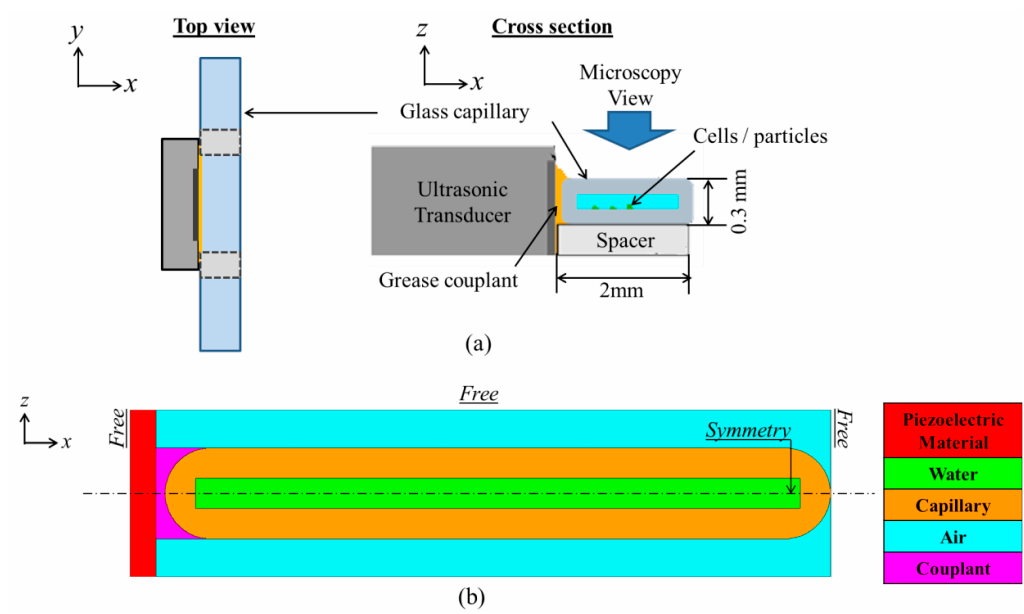
Figure 2. ( a ) Schematic diagram of the planar ultrasonic resonator; and ( b ) PZFlex model of the resonator with assigned materials and boundary